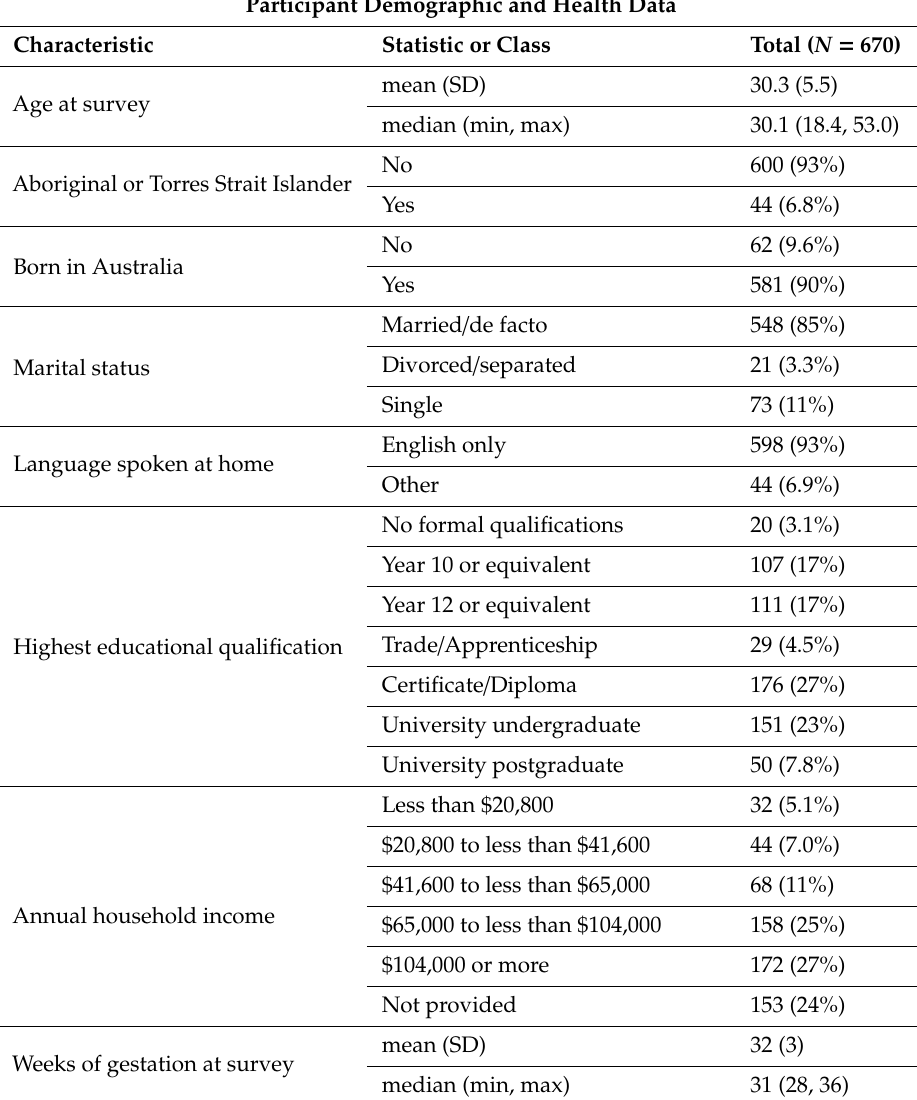
Table 1. Summary of study participant demographic and health